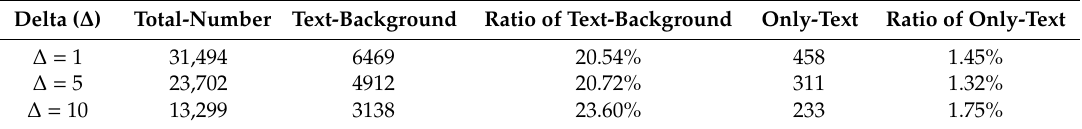
Table 1. The statistics of MSERs-generated components with different Δ on a scene image of ICDAR2013 (International Conference on Document Analysis and Recognition).